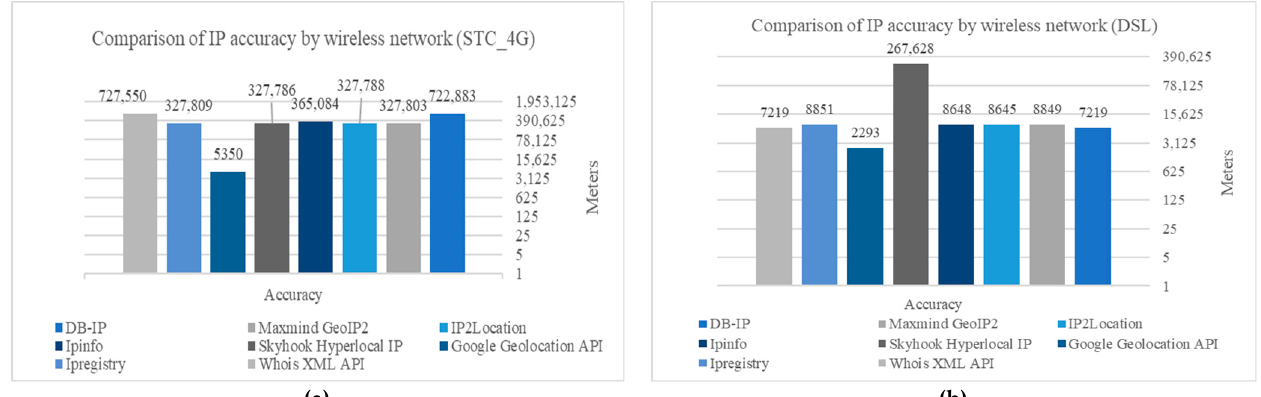
Figure 6. Comparison analysis of the Database-based IP geolocation method. ( a ) Comparison of IP accuracy by wireless network (STC_4G); ( b ) Comparison of IP accuracy by wireless network (DSL).